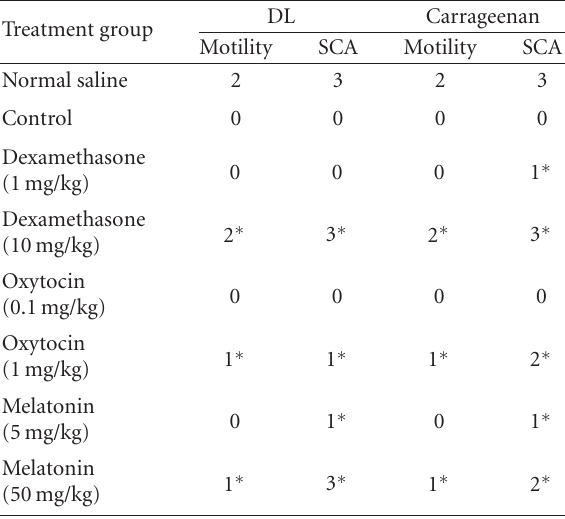
Table 2. E ff ect of various drugs on impairment in motil- ity and stair climbing ability (SCA) associated with DL- and carrageenan-induced inflammation. Edema was induced by in- jecting 0.1 mL of 1% solution of DL or carrageenan into sub- plantar surface of right-hind paw. The drugs were adminis- tered subcutaneously 30 minutes before injecting inflammagen. Motility and staircase climbing ability was observed at the